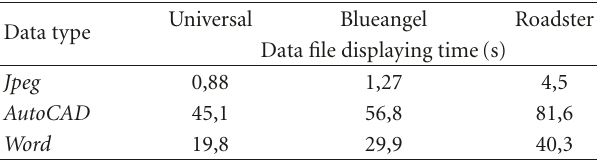
Table 4: Data files displaying tests for 500 kB files (13 iterations).